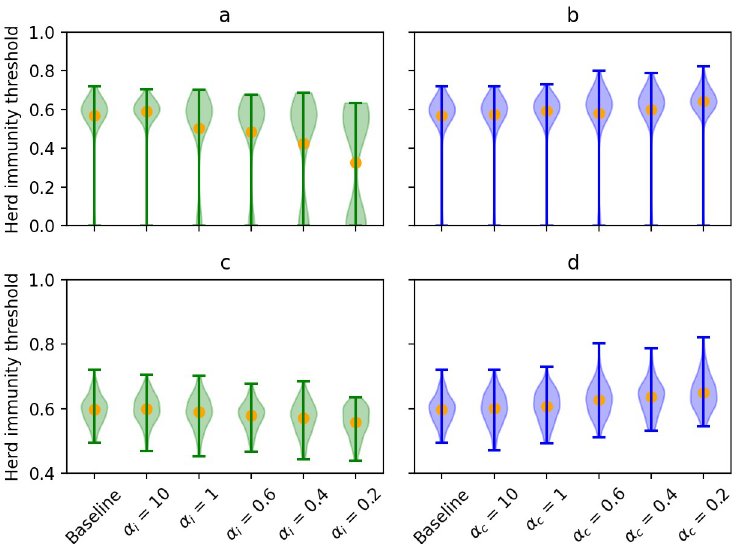
Fig 5. Violin plots of the estimated herd immunity threshold values over the different simulation runs including or excluding runs with extinction for scenarios investigating the infectiousness-related heterogeneity (in green, panels a and c, respectively) and contact-related heterogeneity (in blue, panels b and d, respectively). The orange dots represent the mean of the simulated